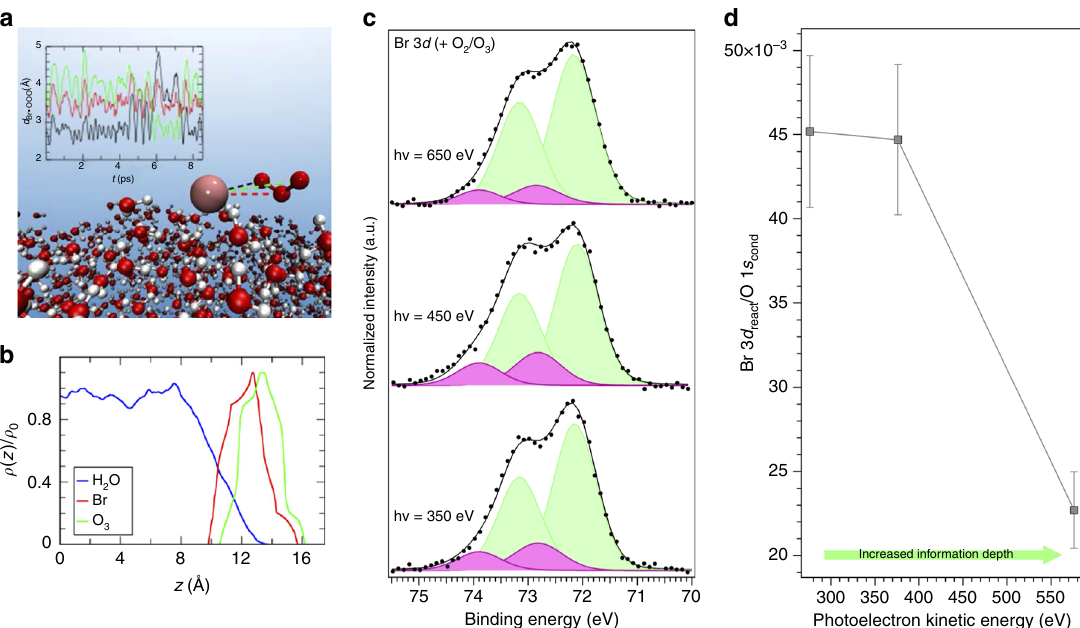
Fig. 4 Surface propensity of [Br (cid:129) OOO − ]. a Snapshot from the fi rst-principle MD trajectory demonstrating the stability of [Br (cid:129) OOO − ] on the surface of liquid water. The inset shows the distances between the bromine and each of the oxygen atoms in the ozone molecule recorded during the 8.5 ps MD trajectory. b From the same trajectory, the bromide and ozone density pro fi le showing the position of the centre of mass of these two groups along the coordinate perpendicular to the interface. In blue , the water pro fi le as reference in arbitrary units. c deconvolution of the Br 3 d photoemission spectra (performed using Gaussian peaks after subtraction of a Shirley background), normalized to the area, acquired at h ν = 350, 450, and 650 eV, and corresponding to photoelectron kinetic energies of 276, 376 and 575 eV (Br 3 d region centroid). d Plot of the intensity of the Br 3 d peaks associated to the [Br (cid:129) OOO − ] complex normalized to the O 1 s (peak acquired with second order light) from the condensed phase (Supplementary Note 4), as a function of the photoelectron kinetic energy. The error bars were calculated by propagating the errors associated with each peak area of three independent